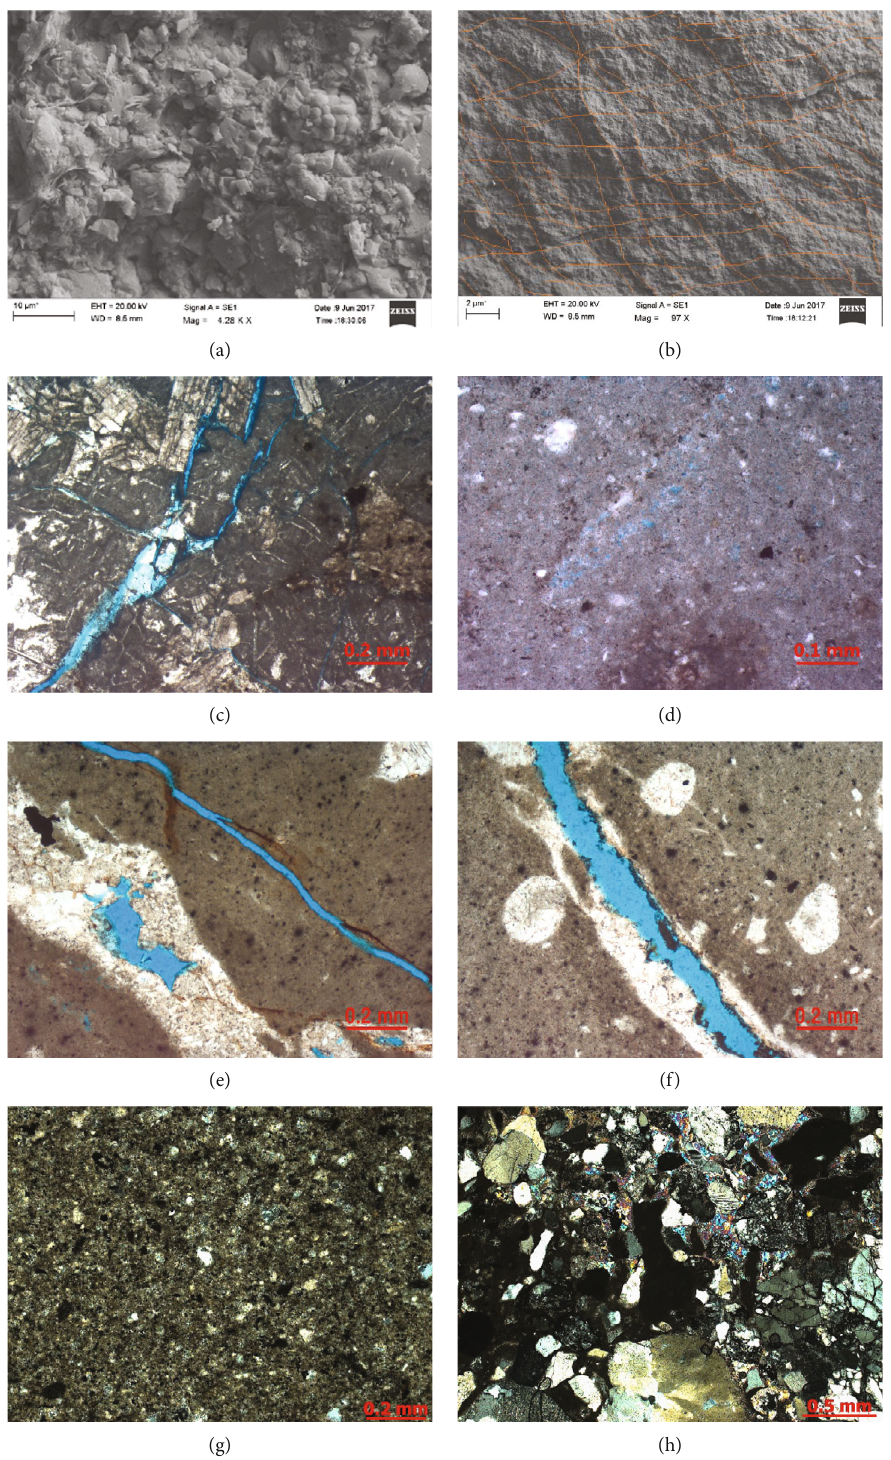
Figure 6: Pore structure of the carbonate reservoirs. (a) Sy35, carbonate and clay mineral intercrystalline pores; (b) Sy30, micro-nano conjugate fractures; (c) Sy60, complex microfractures; (d) Sy42, dissolution pores; (e) Sy18, fracture and residual pores; (f) Sy2, fracture fi lled with gypsum; (g, h) Sy29 and Sy27, thin section analysis of the matrix pore